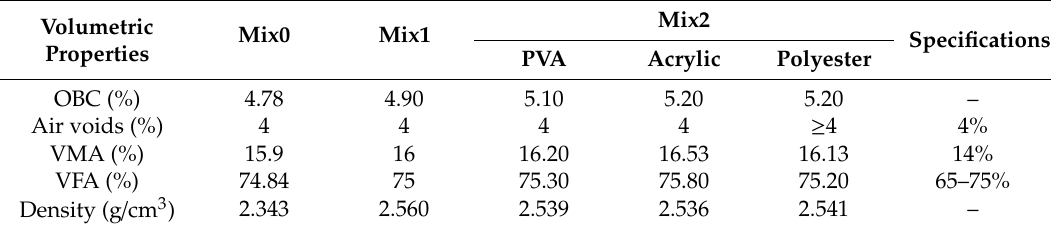
Table 4. The volumetric properties of the asphalt mixtures. OBC: optimum bitumen content, VFA: voids filled with asphalt, VMA: voids in the mineral